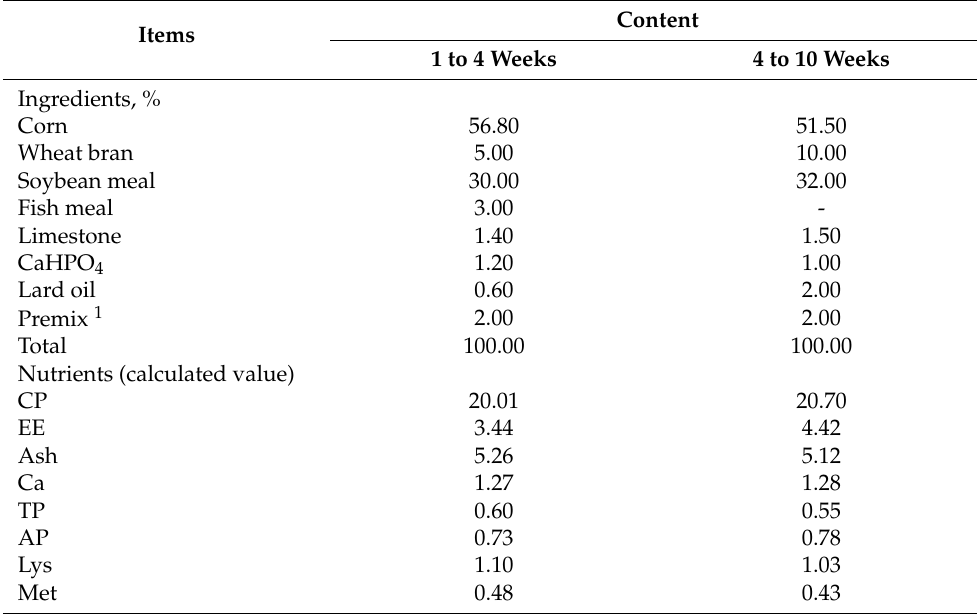
Table 1. Composition and nutrient levels of basal diets (air-dry basis) (%). Items